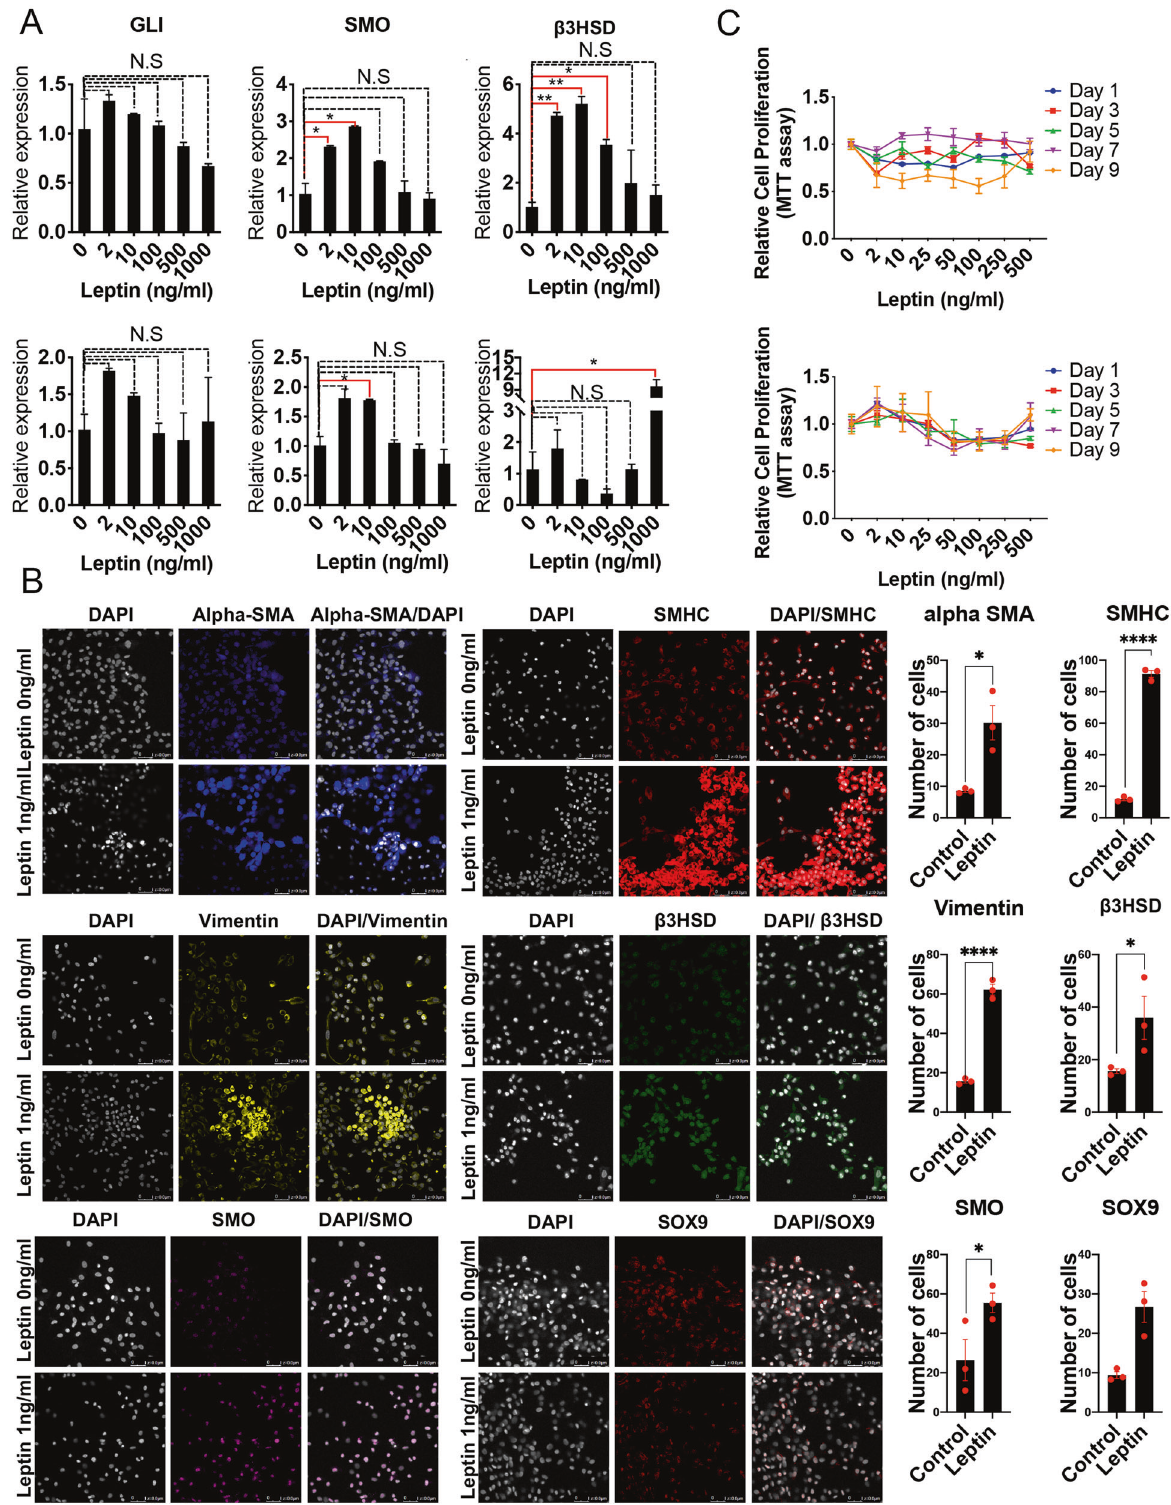
Fig. 3 Studying Paracrine factors released by the TME. A Treatment of cellular composition of the testis (LSCs, ALCs, Sertoli cells, PMCs) with increasing doses of leptin at 0, 2, 10, 100, 500, and 1000 ng/ml, respectively, showing a speci fi c pattern of expression for markers of DHH and LSC differentiation. B Effects of low doses of leptin on protein levels of alpha SMA, SMHC, Vimentin, and B3HSD. C Effects of varying doses of leptin on cell proliferation of cellular composition of the testis. Asterisks denote p values (e.g., * p < 0.05, **** p <